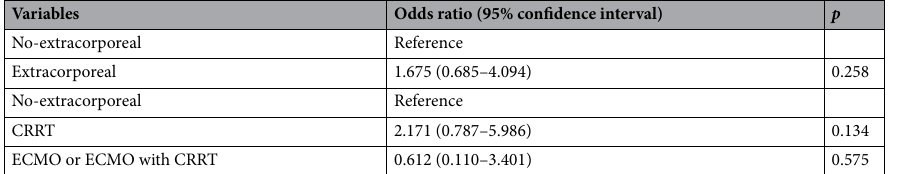
Table 4. The association between poor neurological outcomes and the use of extracorporeal devices. Adjusted with cardiac etiology, witness of collapse, and Glasgow Coma Scale score. CRRT continuous renal replacement therapy, ECMO extracorporeal membrane